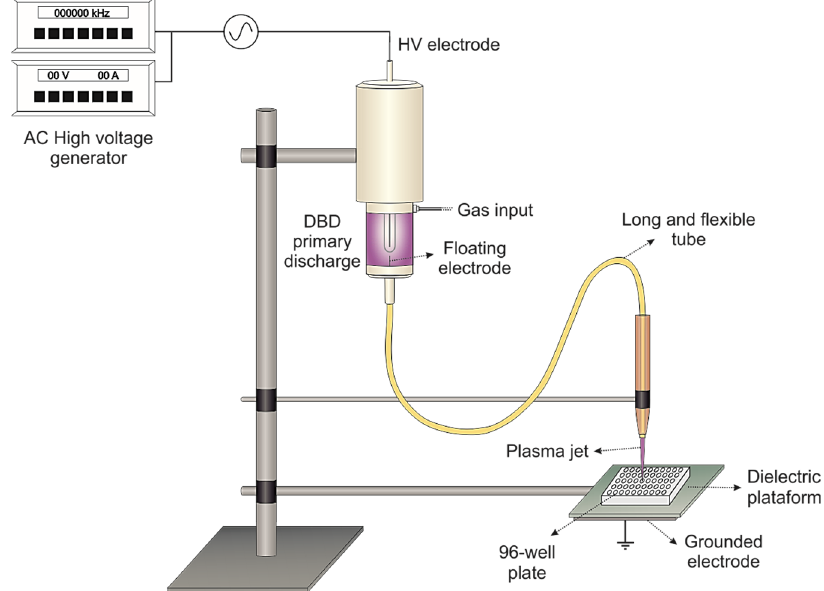
Figure 4. Experimental setup.